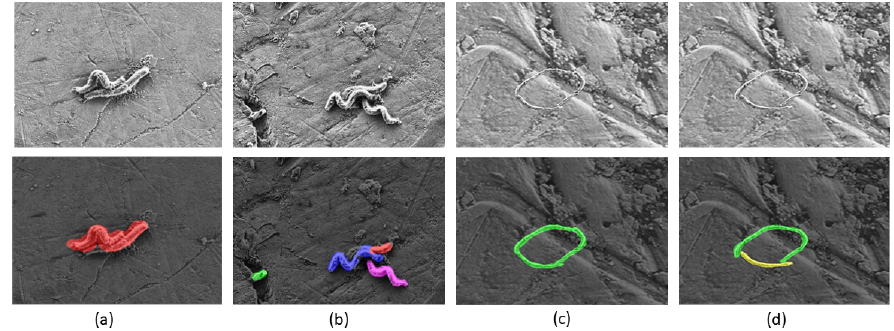
Figure 8. The sample failure cases of the proposed method: ( a ) two or more bacteria cells appear close and parallel to each other; ( b ) the U-Net models output partial semantic segmentation results; ( c , d ) chain-shaped cell arrangements. The first row shows the original SEM images and the second row shows the corresponding instance segmentation outputs from the proposed method where our solution could not obtain accurate cellular